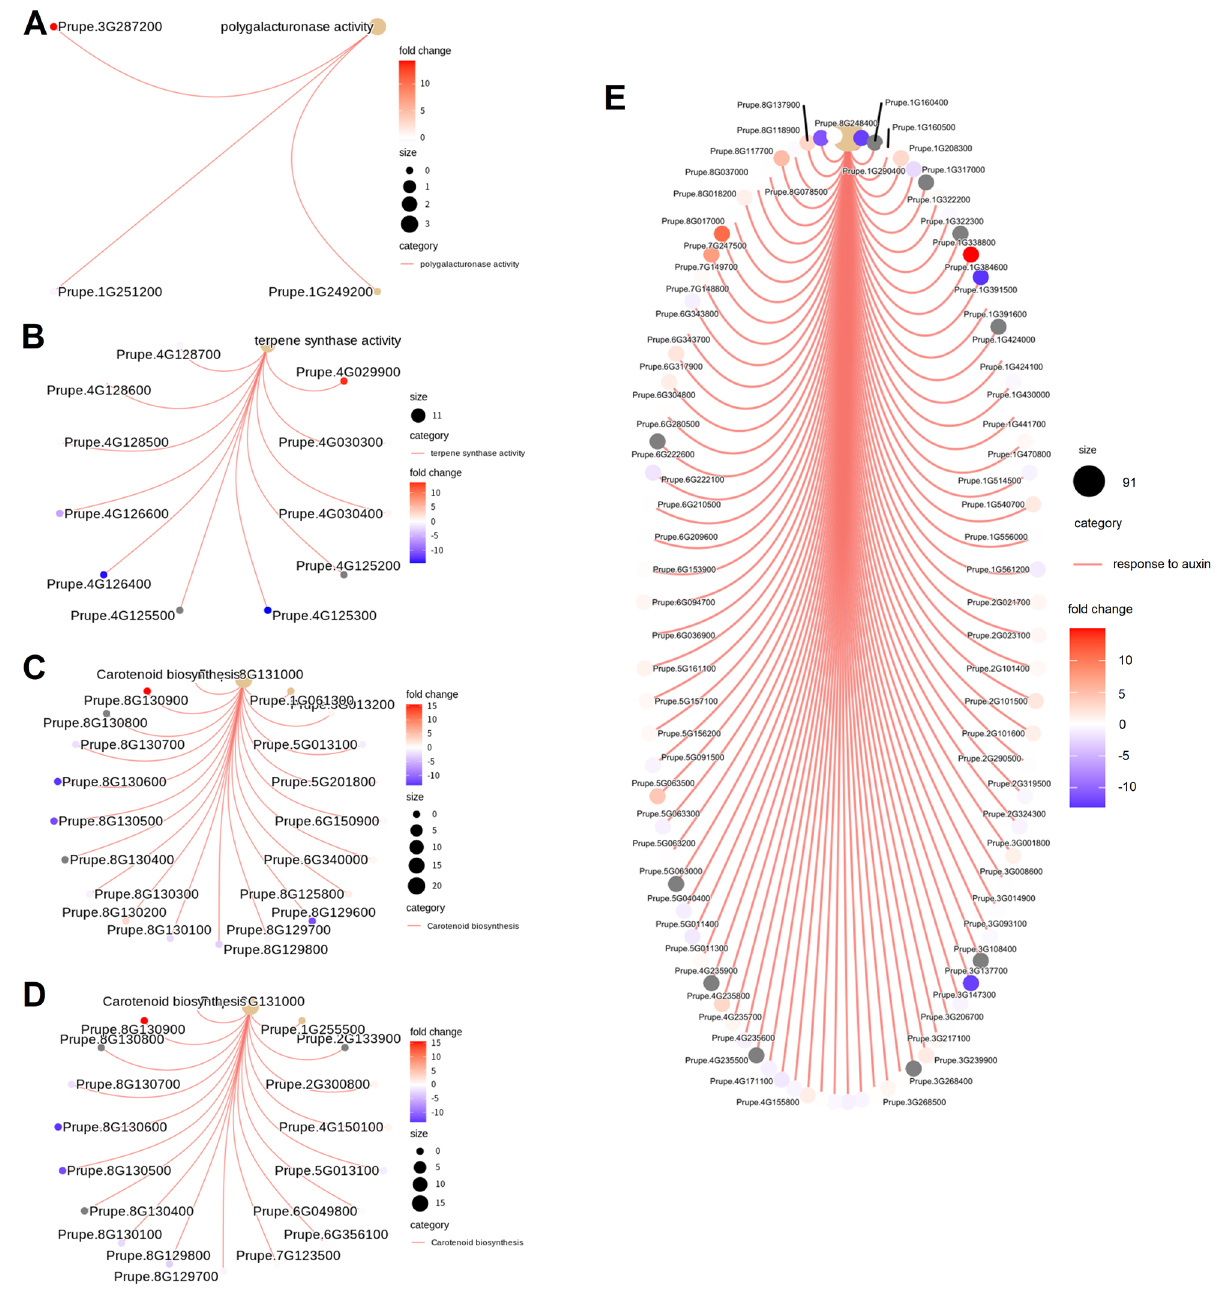
Figure 7. Cnetplot for various GO terms and KEGG pathways associated with putative targets of DELs. ( A ) cis-targets of DELs related to ‘polygalacturonase activity’. ( B ) cis-targets of DELs related to ‘terpene synthase activity’. Cis- ( C ) and trans-targets ( D ) of DELs related to ‘carotenoid biosynthesis’. ( E ) cis-targets of DELs related to ‘response to